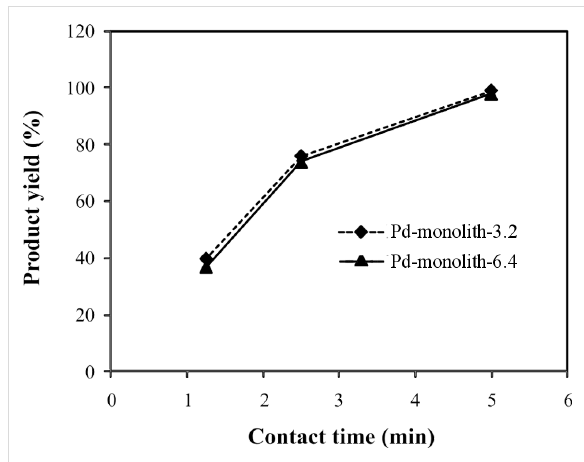
Figure 2: Reactivity of the Pd-monolith-3.2 and Pd-monolith-6.4 for the Suzuki–Miyaura reaction between bromobenzene (0.1 M) and phenyl- boronic acid (0.12 M): The relationship of product yield with contact time.